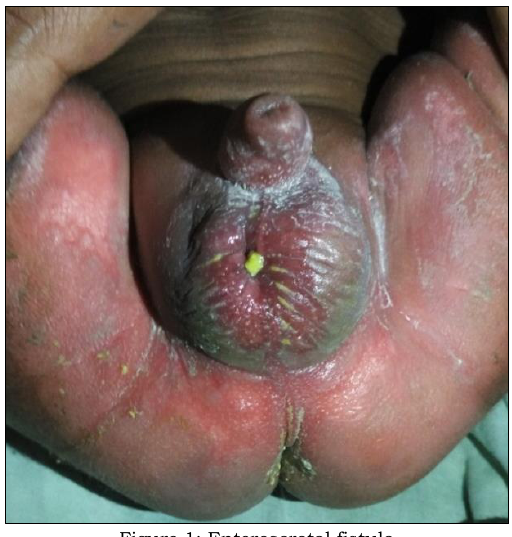
Figure 1: Enteroscrotal